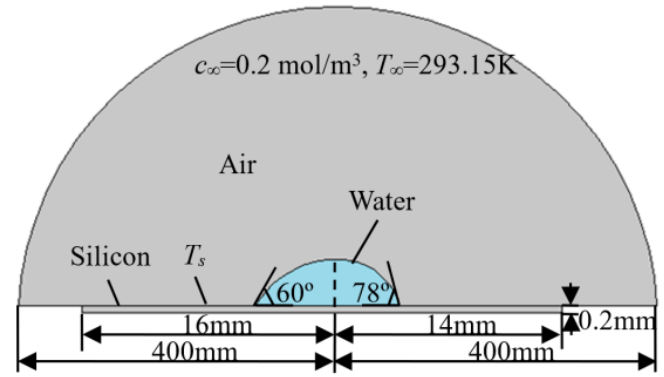
Figure 4. The geometry of the domains.